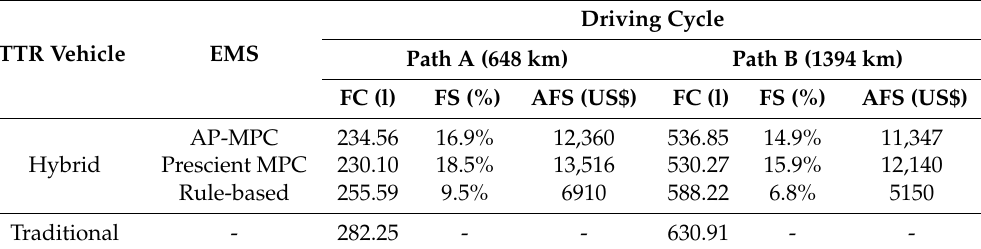
Table 11. Performance comparison among control strategies